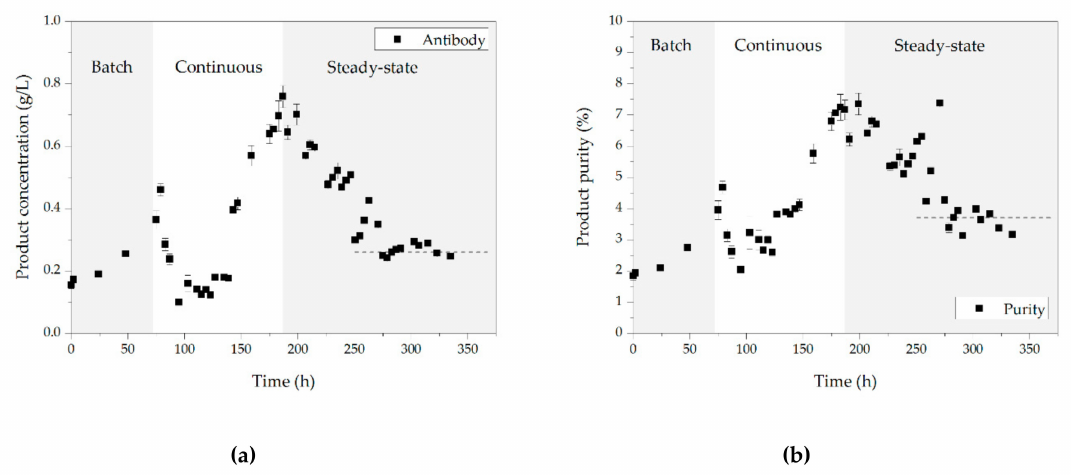
Figure 8. Product concentration ( a ) and purity ( b ) during batch, continuous, and continuous steady-state cultivation. Thehorizontaldashedlinevisualizesschematicallythesubsequentcourseofthesteady-state phase after its initiation at 187 h. Error bars depict the double determination of antibody concentration and purity.